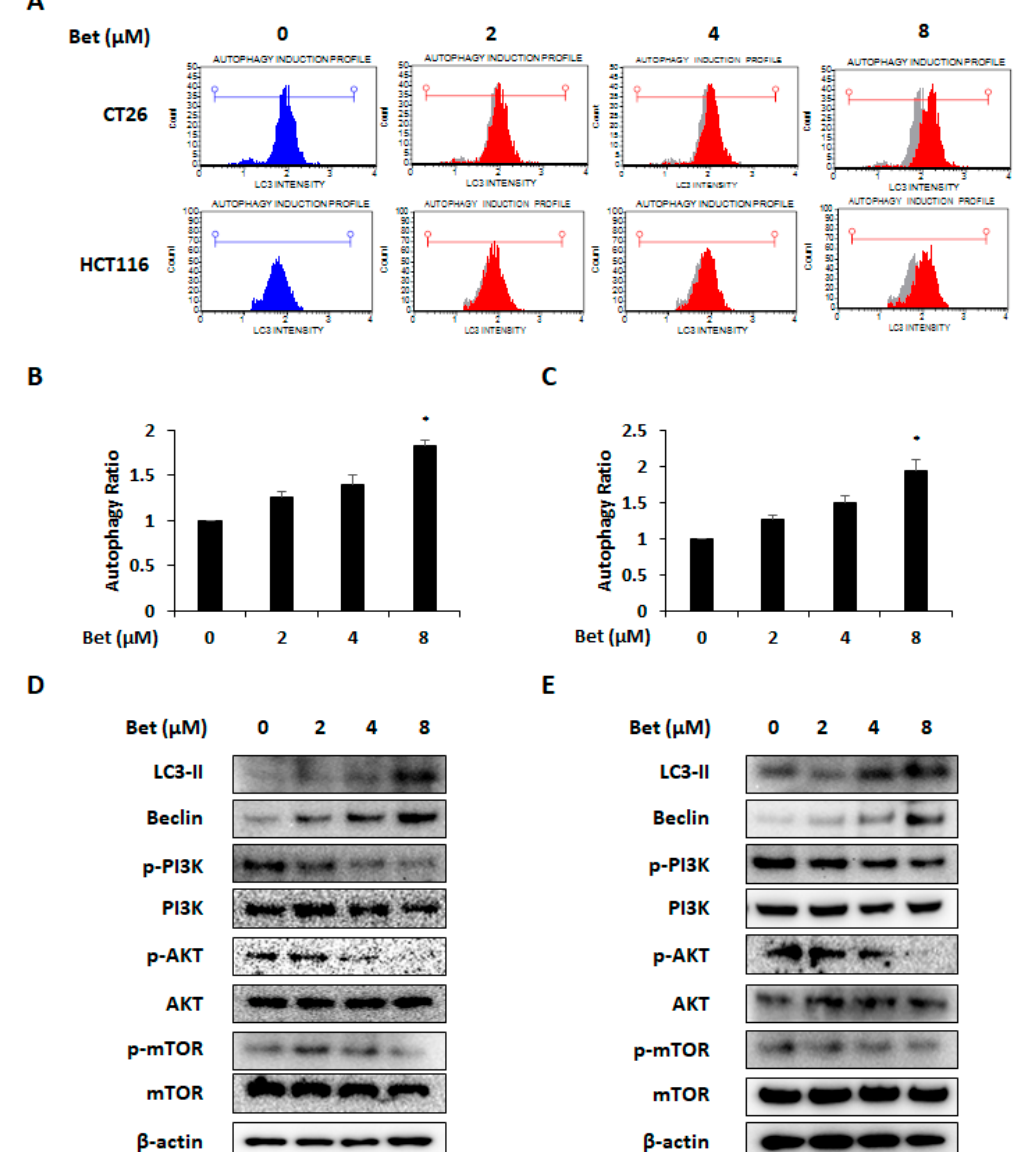
Figure 4. Betulin promotes autophagy of metastatic colorectal cancer cells via PI3K / Akt / mTOR signaling pathway. ( A ) LC3-II expression in betulin-treated CT26 and HCT116 cells was analyzed by flow cytometry. Autophagy ratio of CT26 ( B ) and HCT116 ( C ) cells with betulin treatment for 24 h. Protein bands representing LC3-II, beclin-1, p-PI3K, p-Akt, and p-mTOR in CT26 ( D ) and HCT116 ( E ) cells as detected by western blot analysis. Images represent three independent experiments. Data are means ± standard deviation of three independent experiments. * p < 0.05.